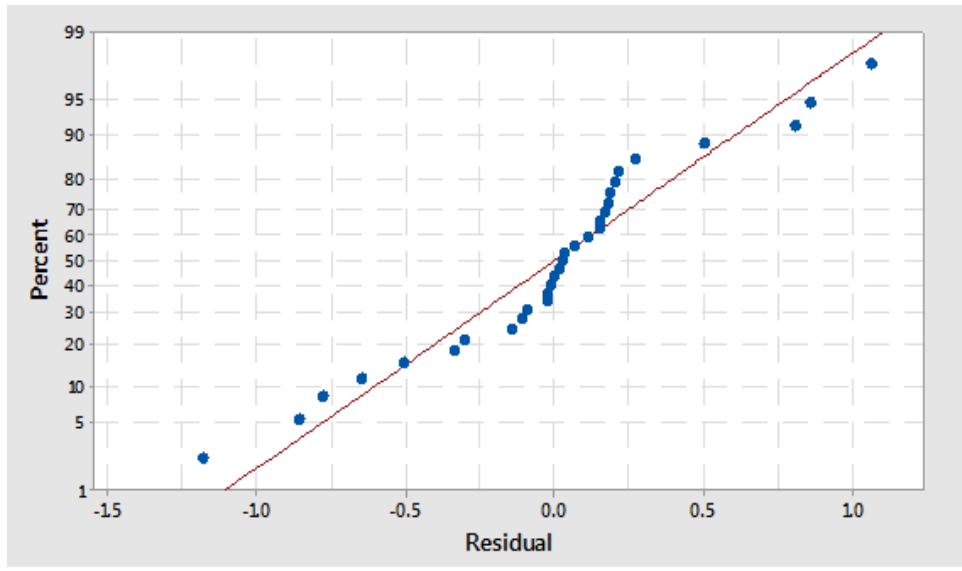
Figure 3. Normality probability plot of usnic acid (%).